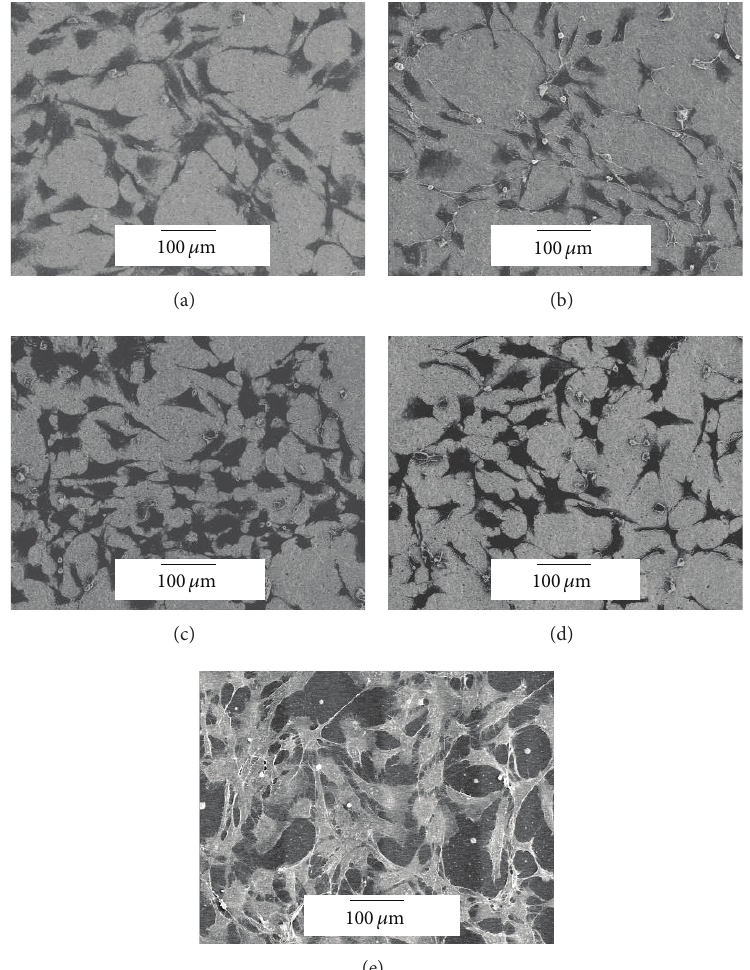
Figure 6: SEM images of cells cultured on TNTZ or CP Ti surfaces. (a) As-prepared TNTZ, (b) as-prepared CP Ti, (c) TNTZ heated at 1000 ∘ C for 1hr, (d) CP Ti heated at 1000 ∘ C for 1hr, and (e) control sample (Thermanox).